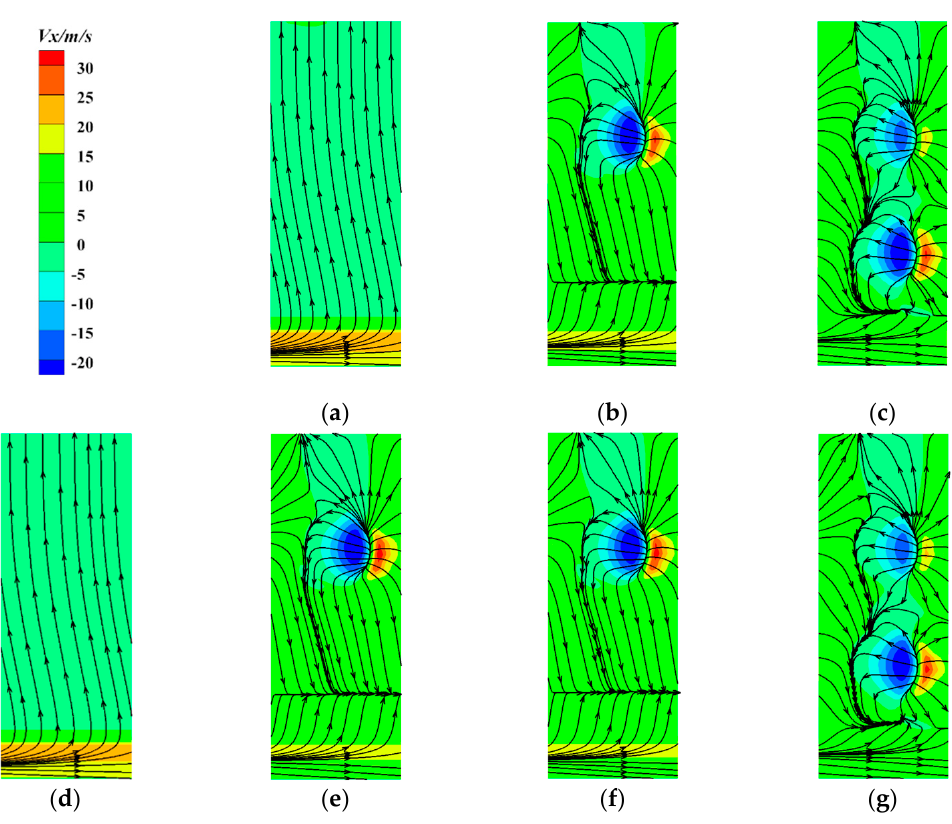
Figure 12. Swirl velocity contours and streamlines on the plane 0.1 mm upstream of the bristle pack: ( a ) Case-1; ( b ) Case-2; ( c ) Case-3; ( d ) Case-4; ( e ) Case-5; ( f ) Case-6; ( g ) Case-7.